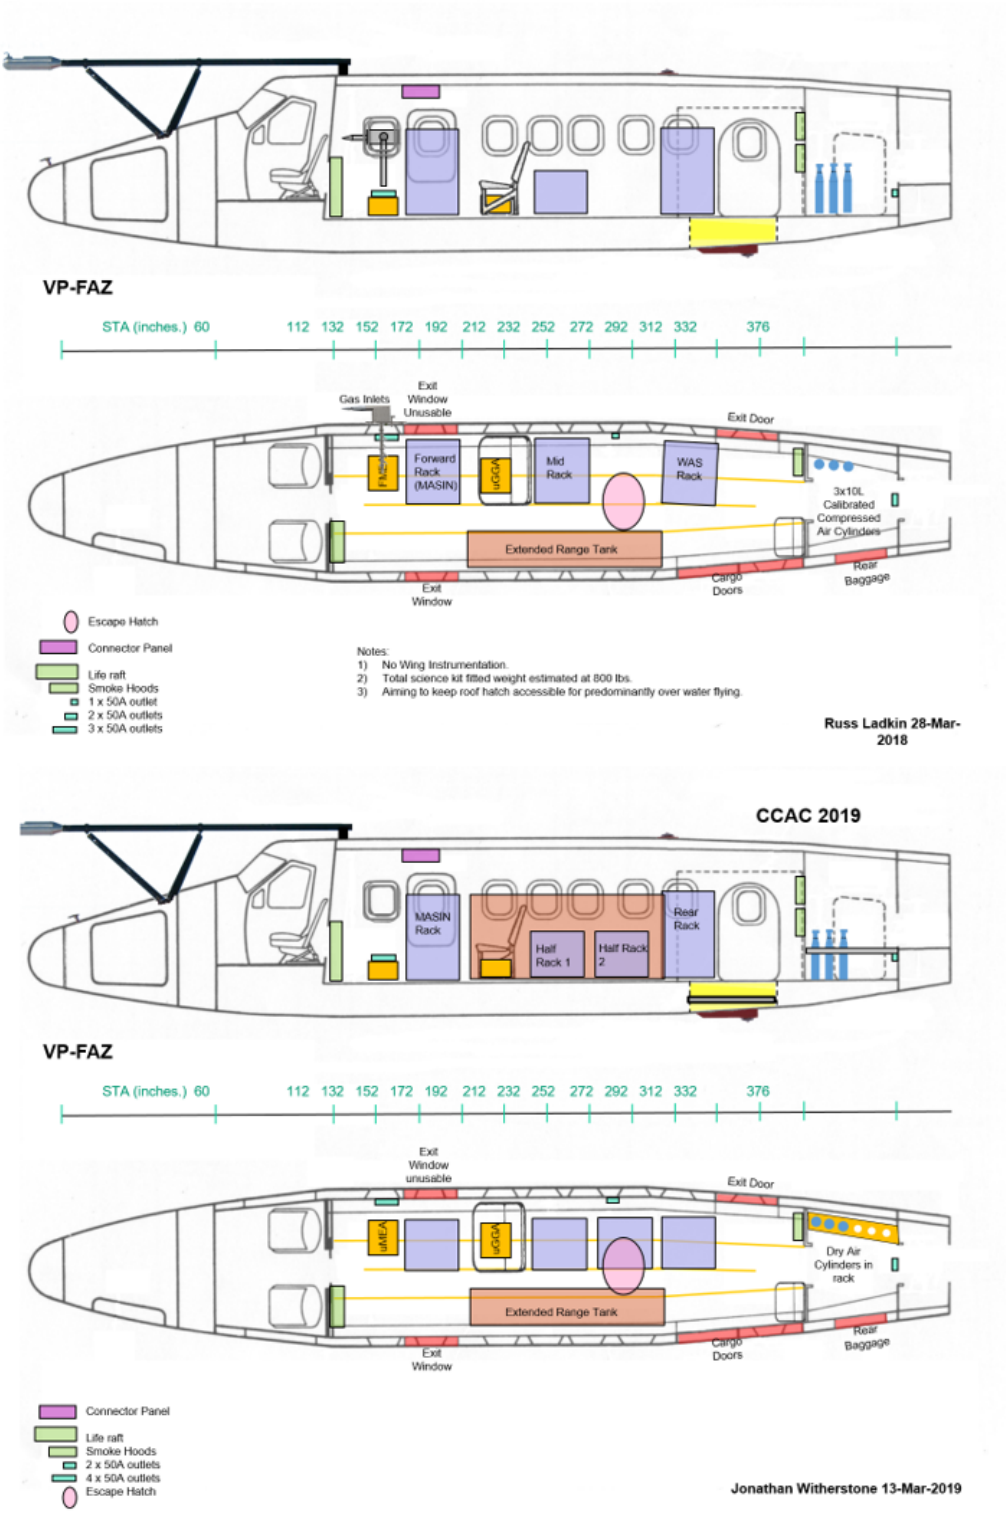
Figure 1. Instrument schematics for the Twin Otter aircraft as deployed in 2018 and 2019, detailing changes in layout and instrumentation between the two campaigns. The top panel is the 2018 fit, and the lower panel is the 2019 fit. VP-FAZ is the Twin Otter aircraft ID. (1in. = 2.54cm; 1lb =